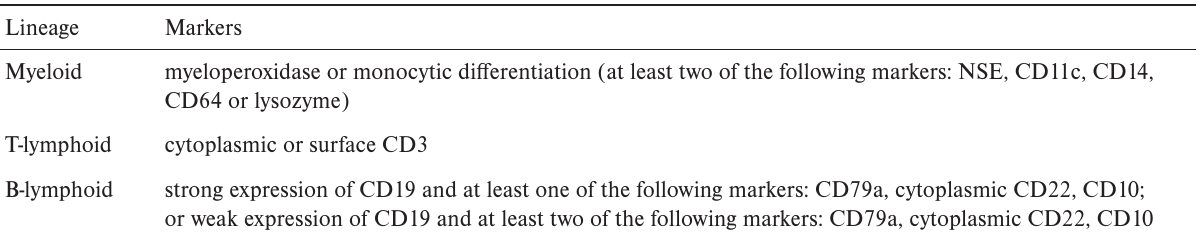
Table 2. Diagnostic criteria for mixed-phenotype acute leukemia according to the WHO revision of classification 2016 (ref. 5 ).